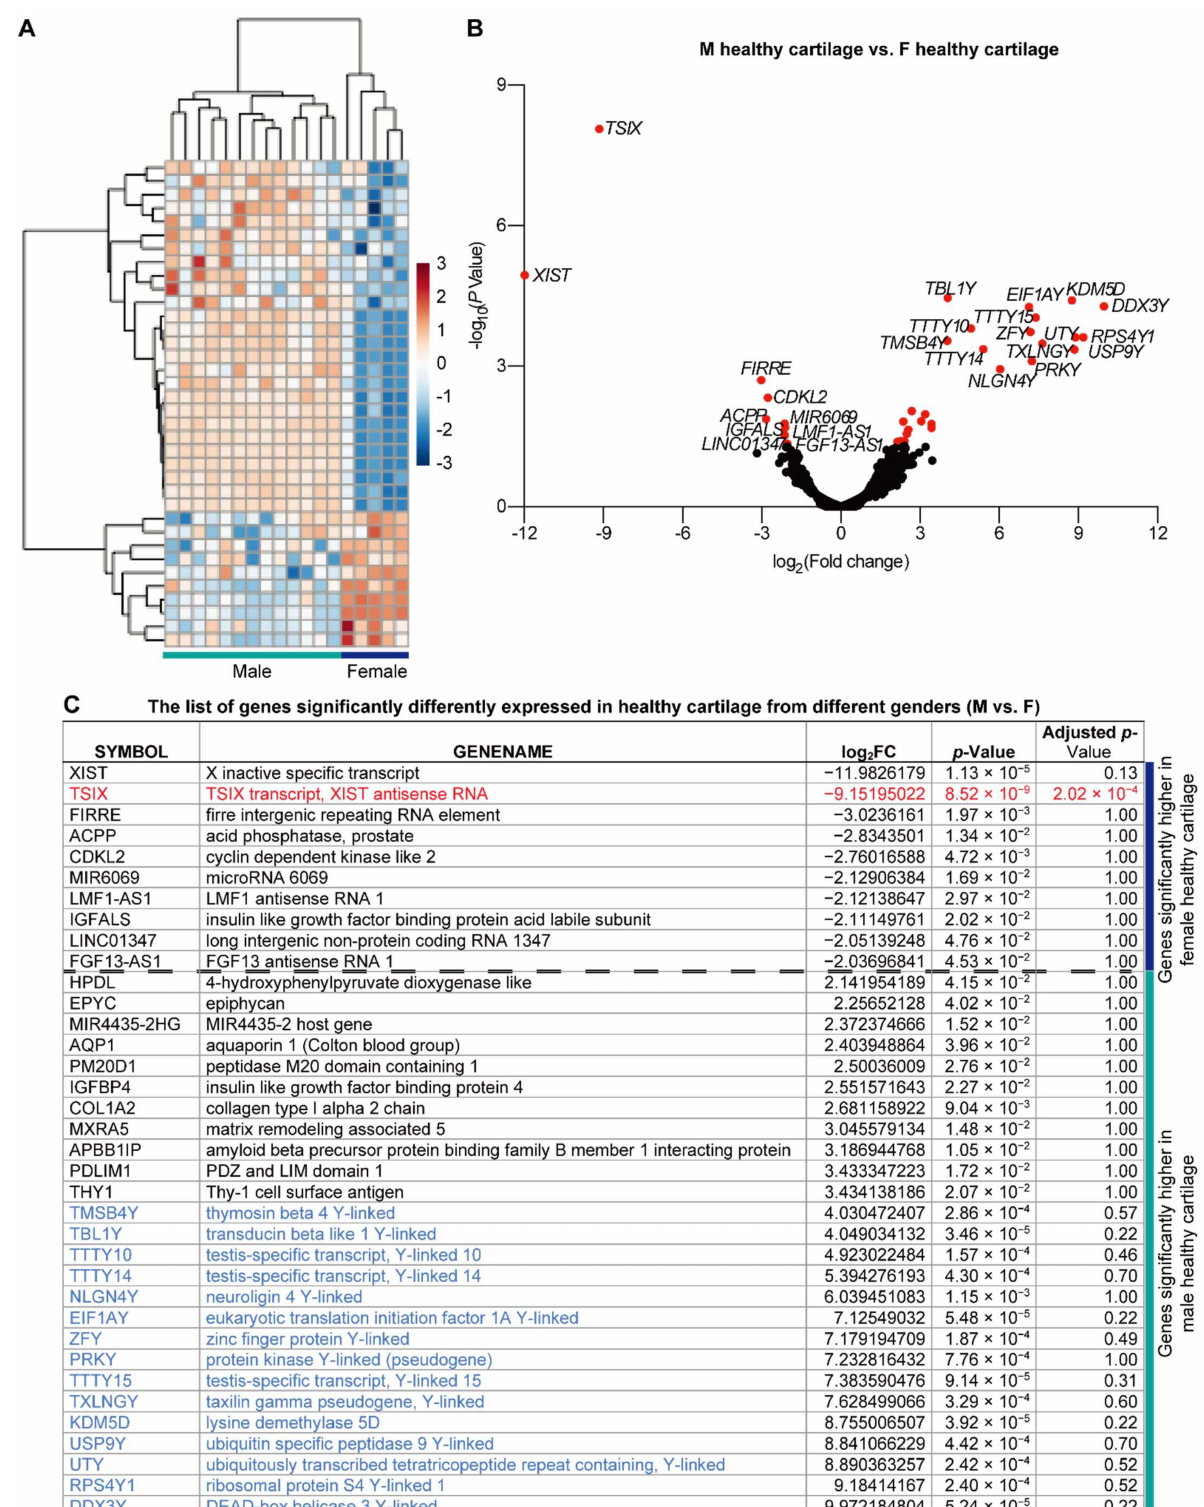
Figure 1. The differential expressed genes (DEGs) detected between male and female healthy knee cartilage samples. ( A ) Heatmap and ( B ) volcano diagrams for DEG visualization. DEGs with a p -value less than 0.05 are highlighted in red. ( C ) The list of genes that are significantly differentially expressed in healthy male and female cartilage. DEGs with a statistically significant higher level in females have a negative log 2 FC value, while those highly expressed in males have a positive log 2 FC value. The gene with an adjusted p -value less than 0.05 is highlighted in red. The Y-chromosome linked genes are highlighted in blue